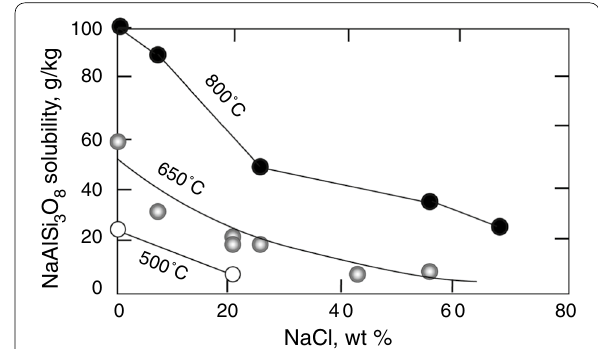
Fig. 22 Solubility of NaAlSi 3 O 8 in H 2 O–NaCl fluid in the system NaAlSi 3 O 8 –H 2 O–NaCl as a function of NaCl concentrations at 0.9 GPa and temperatures shown on individual curves. Modified after